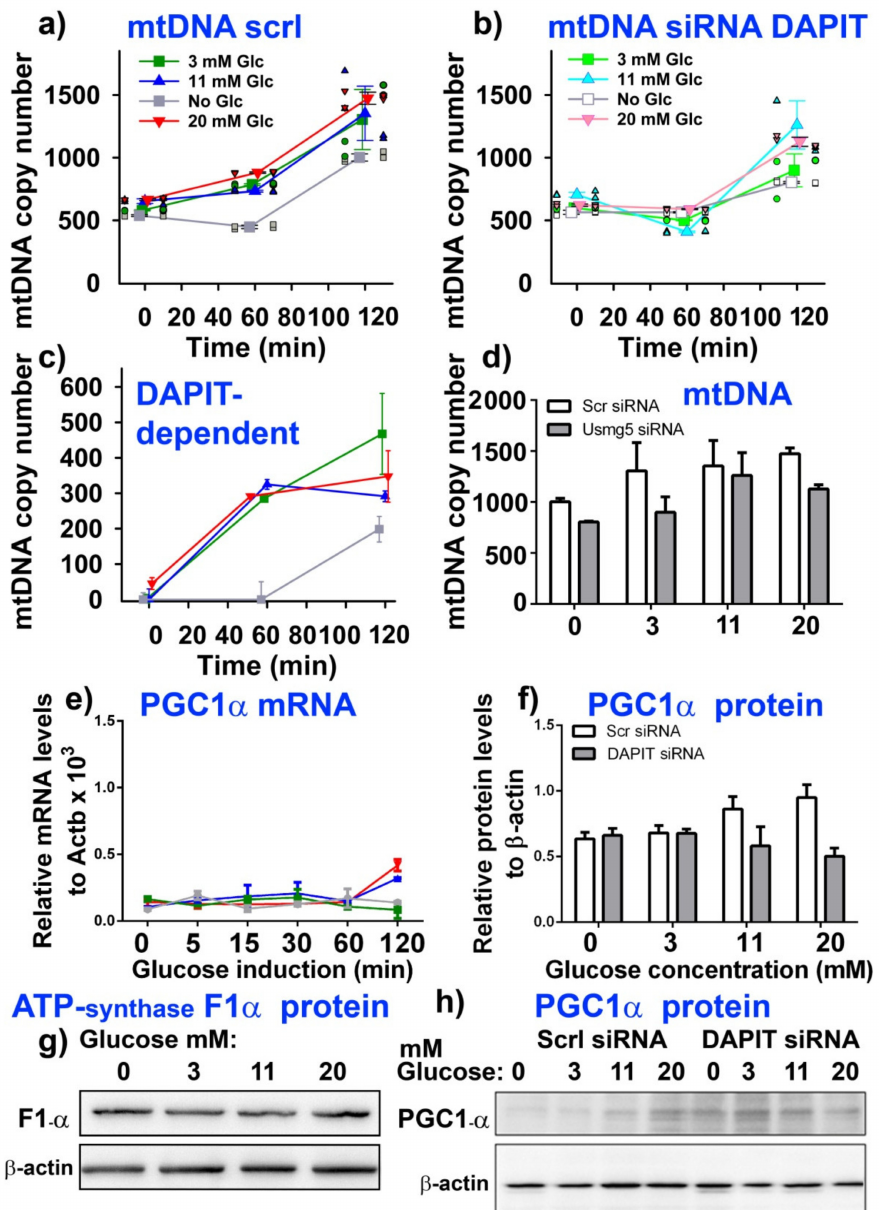
Figure 5. Glucose-induced expression of mitochondrial biogenesis. Time course ( a – c ) and glucose concentration dependence ( d ) for DAPIT-dependent increase in mitochondrial DNA copy number. Panels ( a , b ) show individual data plus their averages, while ( c ) shows the DAPIT-dependent increase in copy number. Changes in transcript of PGC-1 α ( e ) and PGC-1 α protein ( N = 3) ( f , h ) and F 1 α protein ( g ) are shown. ANOVA ( N = 4): ( a , b ) vs. zero glucose: ** p < 0.05; *** p < 0.001. Full size western blot of panel ( g ) and F 1 α mRNA see Supplementary File 1, Figure S4. For ( e ), thresholds yielded by